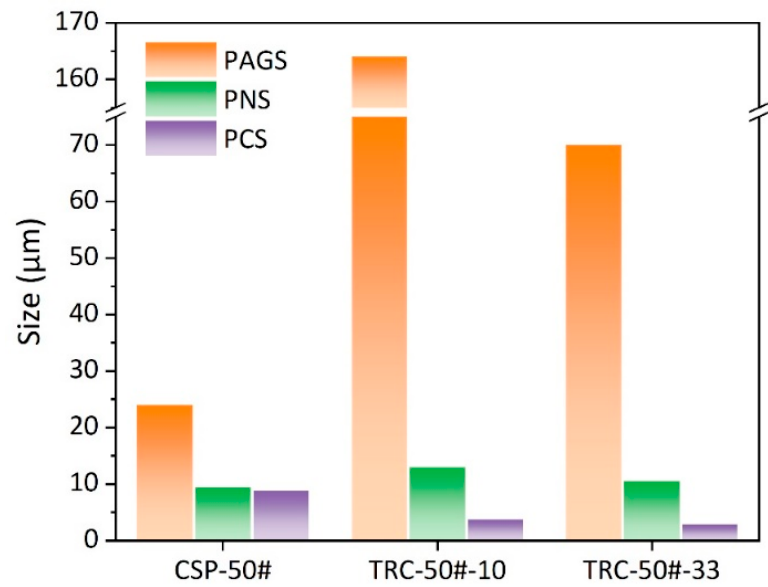
( d – f ) SEM images of CSP-50#, TRC-50#-10 and TRC-50#-33 showing the characteristics of their pearlitic structure. ( g – i ) Inverse pole figure (IPF) maps of CSP-50#, TRC-50#-10 and TRC-50#-33 showing the distribution of pearlite nodule. Some of the colony boundaries are marked with white dashed lines. The proeutectoid ferrites are marked by brown arrows. The nodule boundaries are marked by black arrows.